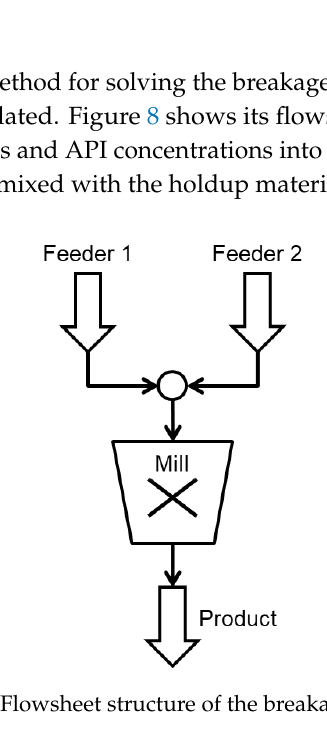
Table 3. Model parameters used for breakage process.